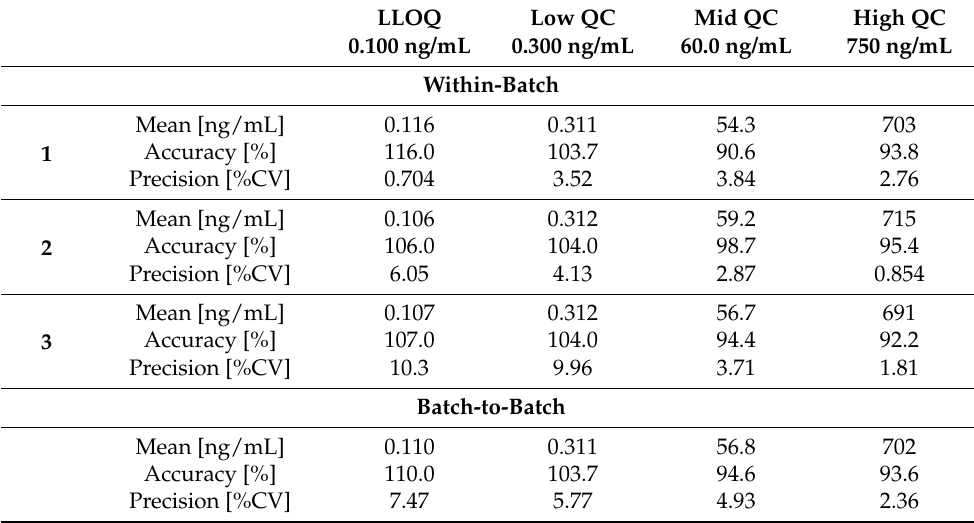
Table 2. Quality control results of the